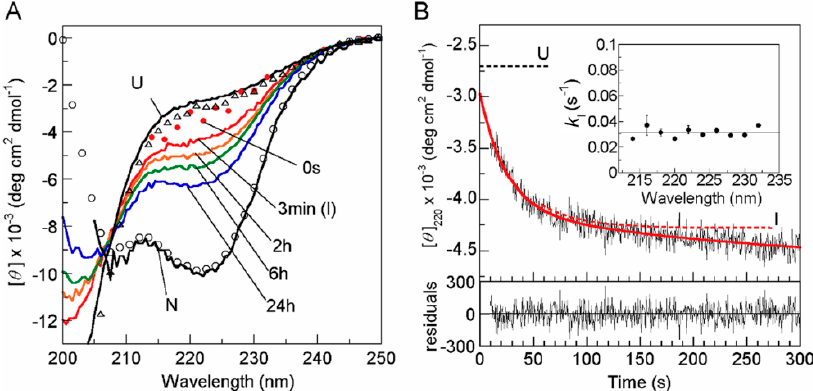
Figure 3. Representative far-UV CD spectra recorded during the folding of cytochrome c at 25 °C and pH 4.5 in a silica gel containing 80% ( w / w ) water. ( A ) The times indicated are those after initiation of the folding reaction. The red circles correspond to the mean residue ellipticity [ θ ] obtained by the extrapolation of kinetic curves to time zero. The solid black lines represent the spectra of the N and U states in gel. The open circles and triangles are the [ θ ] values of the spectra of the N and U states, respectively, in solution. Note that the spectra of the solution N and U states were recorded using the same folding and unfolding conditions as were used for the gel measurements. ( B ) A representative kinetic curve plotted using the [ θ ] at 220 nm for the initial resolvable cytochrome c in-gel folding phase at 25 °C. The times are those after initiation of the folding reaction. The thick red line is the fitted curve drawn using a multi-exponential decay function. The dotted red curve is the single exponential curve. The dotted black line in the upper panel is the [ θ ] at 220 nm for the U state. The residuals are shown in the lower panel. The inset shows the rate constants of the initial phase calculated for different wavelengths. Reproduced with permission from [16].